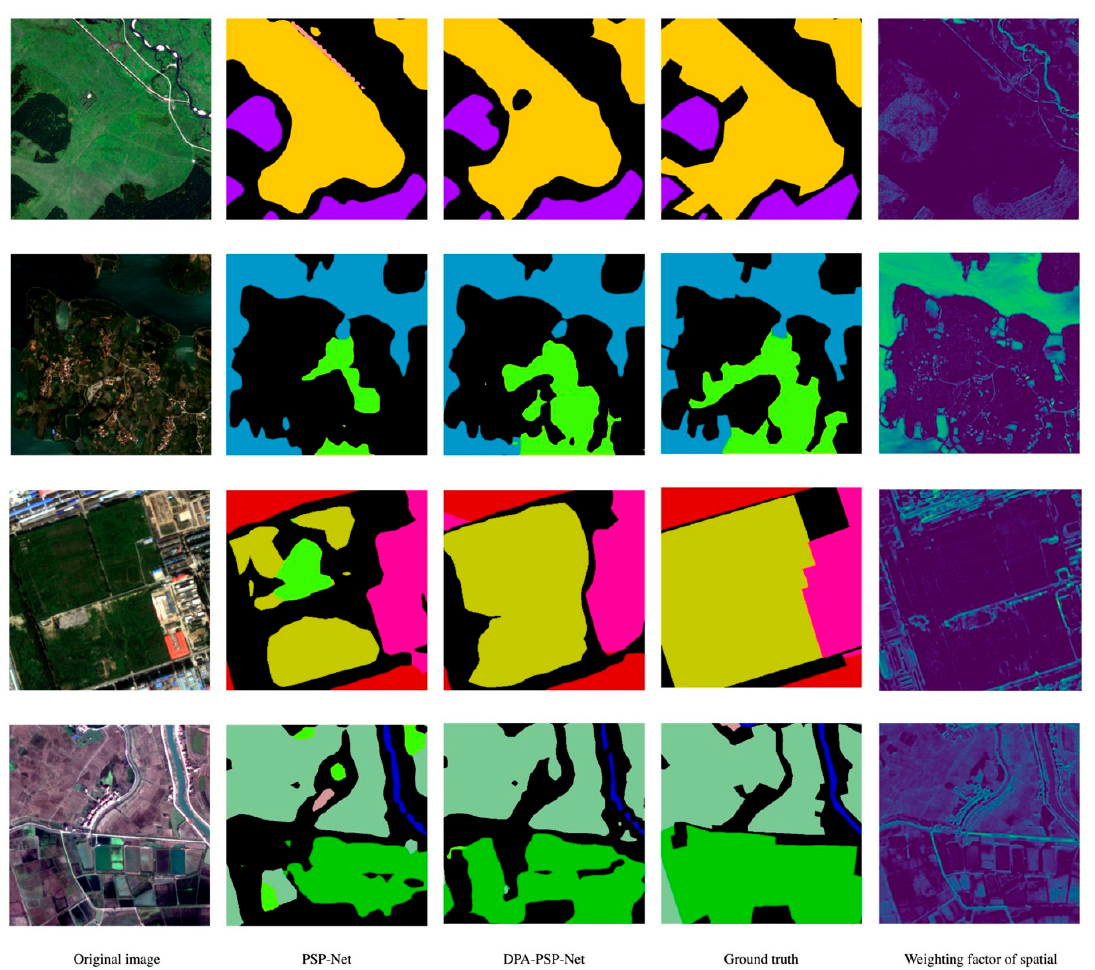
Figure 9. Visual performance of PSP-Net with and without DPA-Net on the GID dataset.